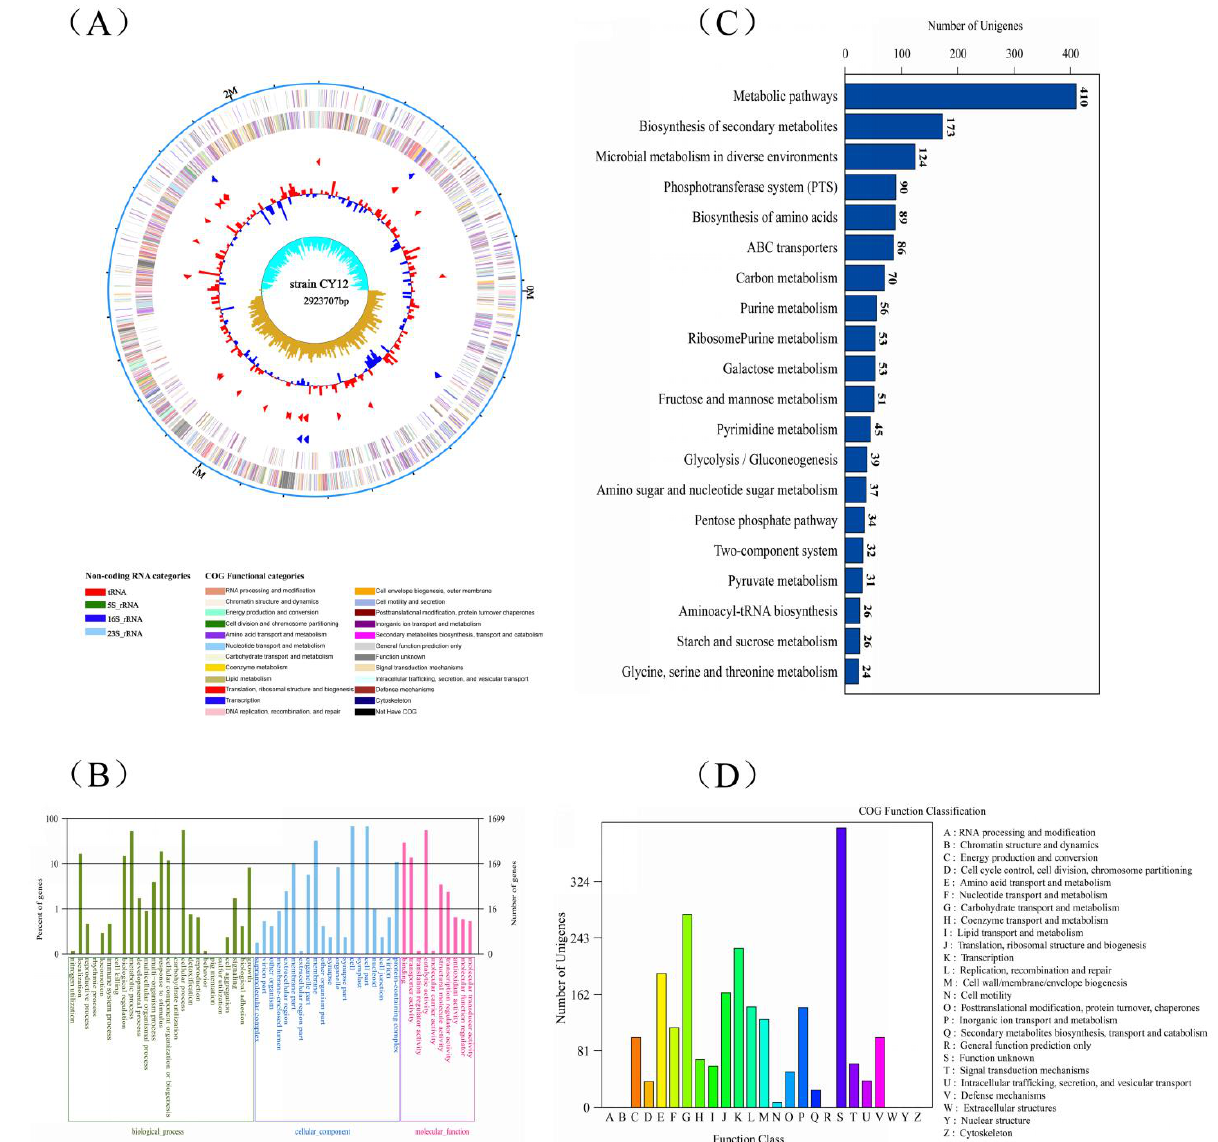
Figure 3. Whole-genome sequencing of selected strains. ( A ) The complete circular genome map of strain CY12; the outermost circle of the circle diagram is the marker of genome size, and each scale is 0.5 MB; the second and third circles are CDS on the positive and negative chains. Different colors indicate the functional classification of different COG of CDS. The fourth circle is rRNA and tRNA; the fifth circle is GC content. The outward red part indicates that GC content in this region is higher than the average GC content in the whole genome. The higher the peak value, the greater the difference between GC content in this region and the average GC content. The innermost circle is the GC skew value, and the specific algorithm is G-C/G + C. In the biological sense, when the value is positive, the positive chain is more inclined to transcribe CDS; when the value is negative, the negative chain is more inclined to transcribe CDS (the form of the circle graph is flexible, and the above is only the most traditional form); ( B ) gene ontology (GO) analysis of strain CY12 genome; ( C ) KEGG pathways enrichment for strain CY12 genome; ( D ) the Clusters of Orthologous Groups of proteins (COG) functional classification of the CY12 strain genome.